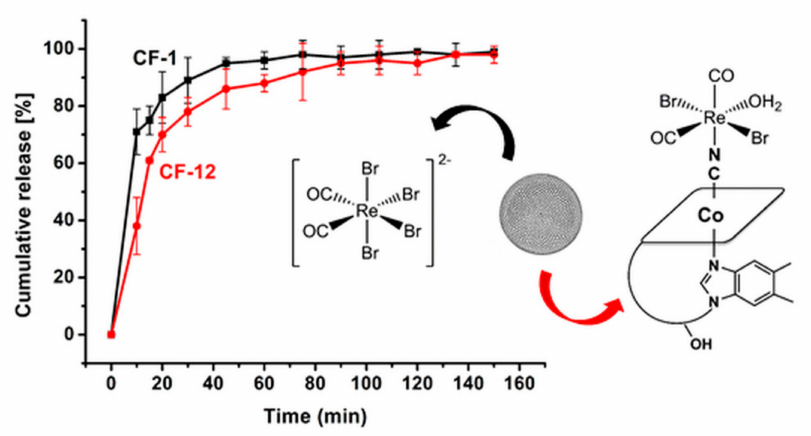
Figure 5. Cumulative [%] of Re metal released in PBS bu ff er, pH 7.4, by CF-1 (black line) and CF-12. The cumulative [%] of Re metal in solution is taken as a measure of drug